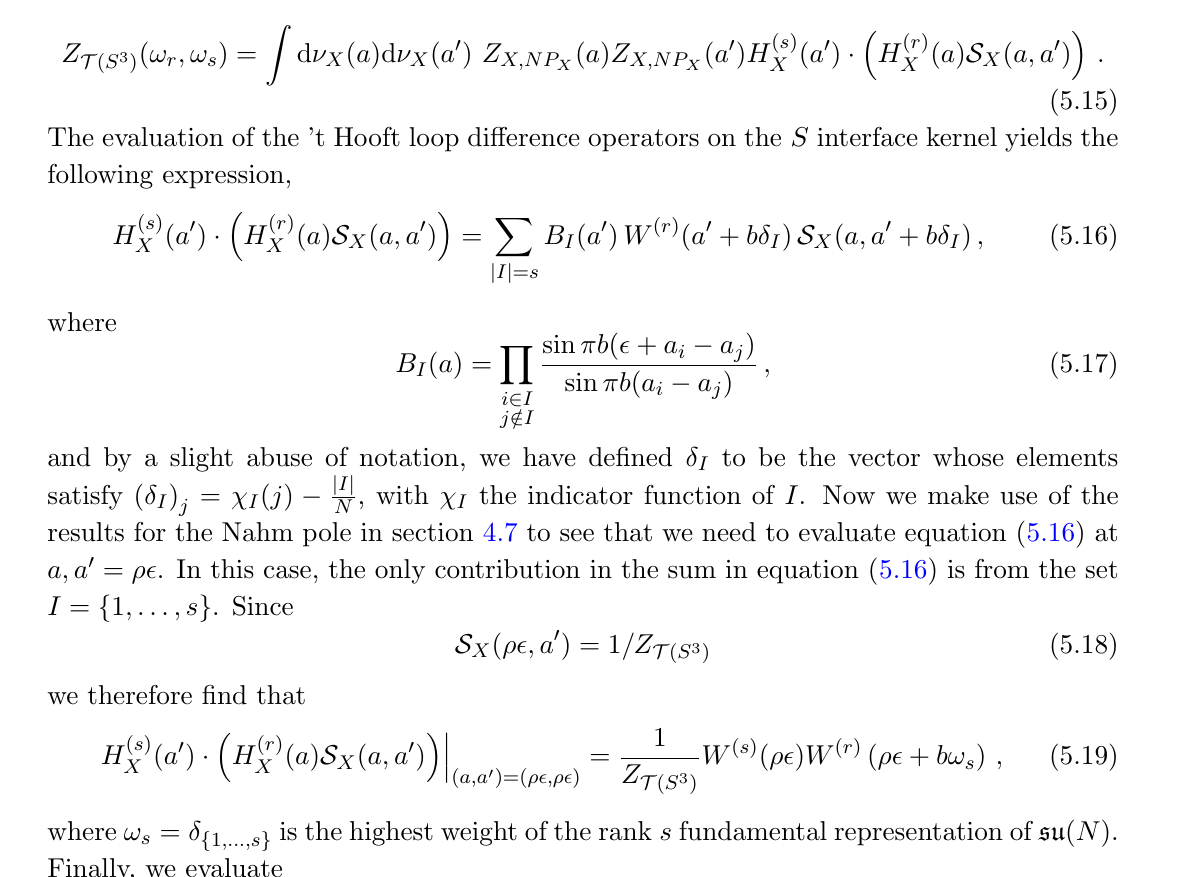
Figure 19 . The partition function for Hooft loop operators. This partition function is symmetric in r and s because in our conventions operators in diagrams act to the